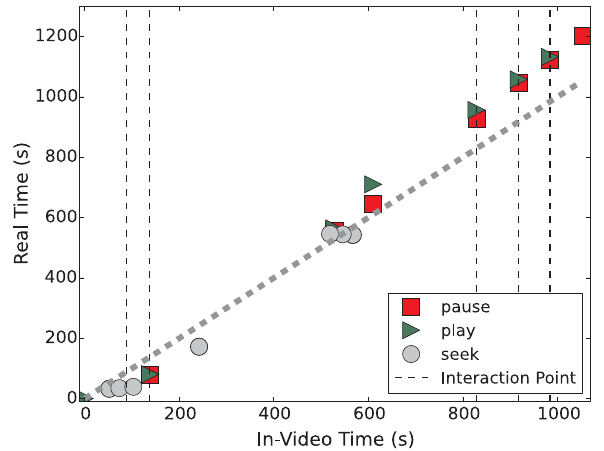
FIG. 1. The “ accessing trajectory ” of a single student. The dashed diagonal line represents where video time and real time are